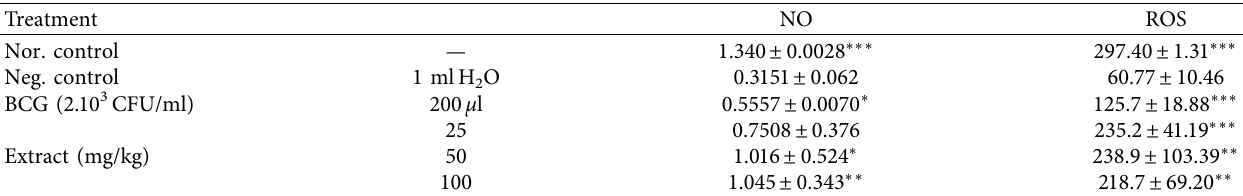
Table 4: Effect of the crude polysaccharide of T. le-testui on serum level of nitric oxide and reactive oxygen species production in methylprednisolone-treated rats.